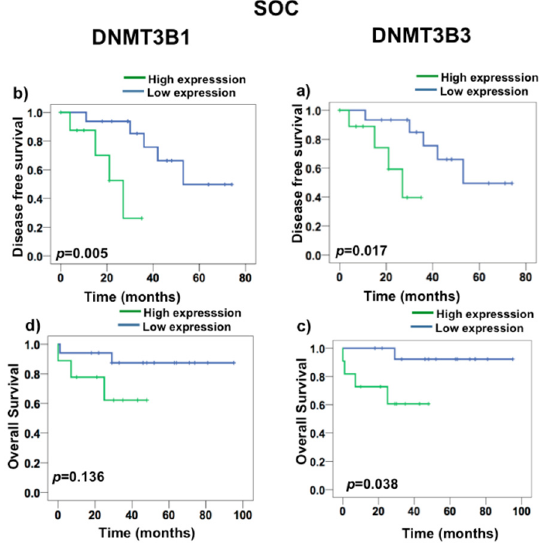
Figure 6. DNMT3B3 overexpression is associated with disease-free survival in ovarian carcinoma (SOC). DNMT3B1 expression in Kaplan–Meyer survival analysis in EOC: ( a ) DFS and ( b ) OS, and in SOC: ( c ) DFS and ( d ) OS. The log rank test was used to calculate the significant differences among overexpression (n = 46) versus no overexpression (n = 23) groups.